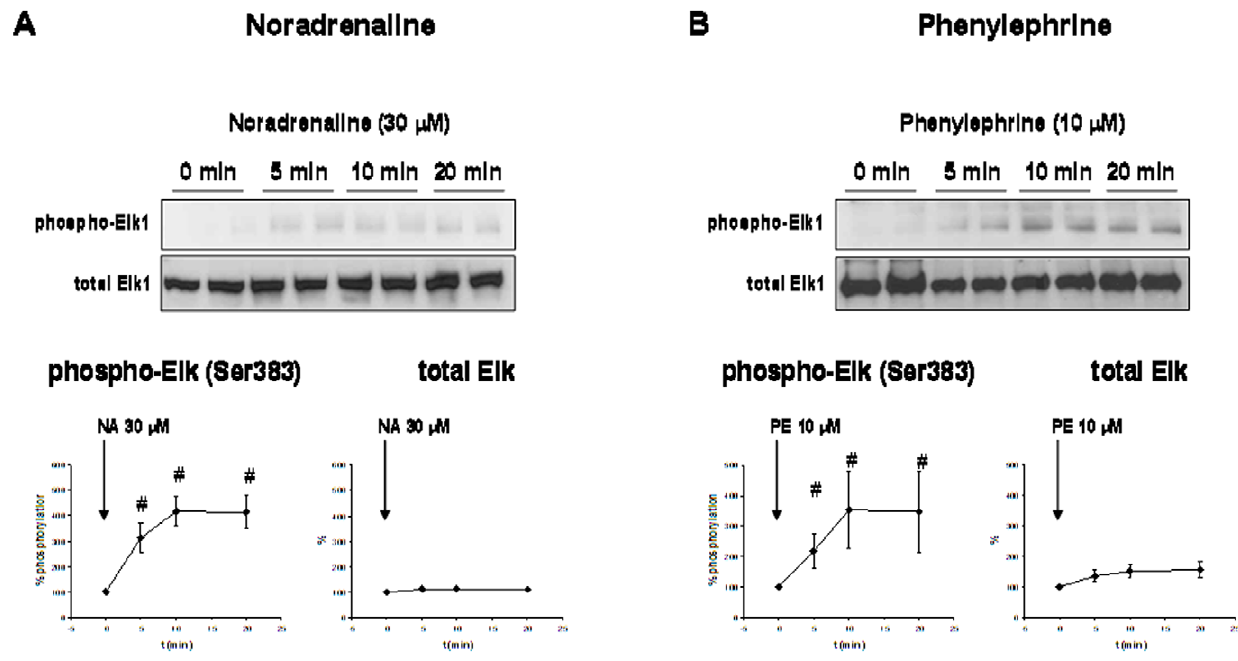
Figure 3. Adrenergic Elk1 phosphorylation in human prostate tissue. Prostate tissue from each patient was allocated to four samples, which were stimulated for indicated periods. Despite different stimulation periods, all samples were exposed for identical total periods to experimental conditions to prevent agonist-unspecific effects. Phosphorylation state of Elk1 and total Elk1 content was assessed by Western blot analysis. In each experiment, phospho-Elk1 and total Elk1 in unstimulated samples (=0 min) was set to 100%, and values for stimulated samples were referred to the unstimulated sample. ( A ) Stimulation with NA (n=5 patients). ( B ) stimulation with the a 1-AR agonist PE (n=11 patients). Shown are representative Western blots, and densitometric quantification of all experiments (means 6 SEM).